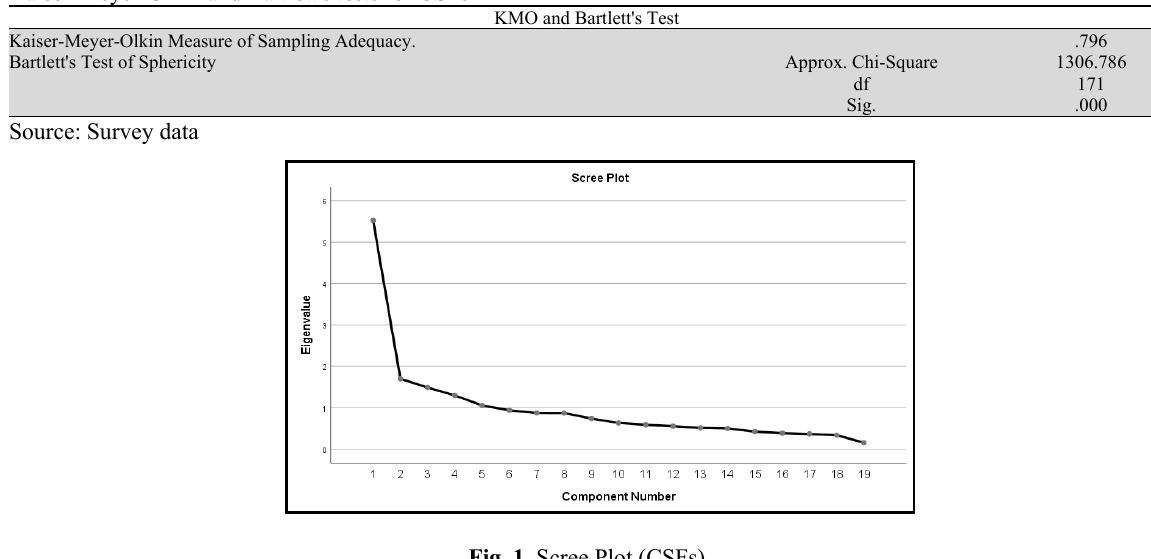
Fig. 1. Scree Plot (CSFs)